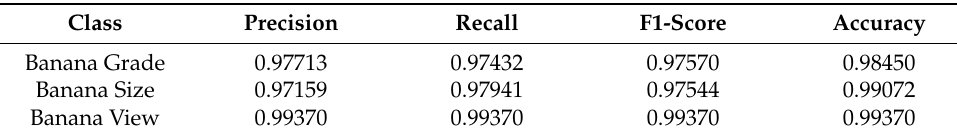
Table 5. Metrics classification report for all model classifiers developed in this study. Class